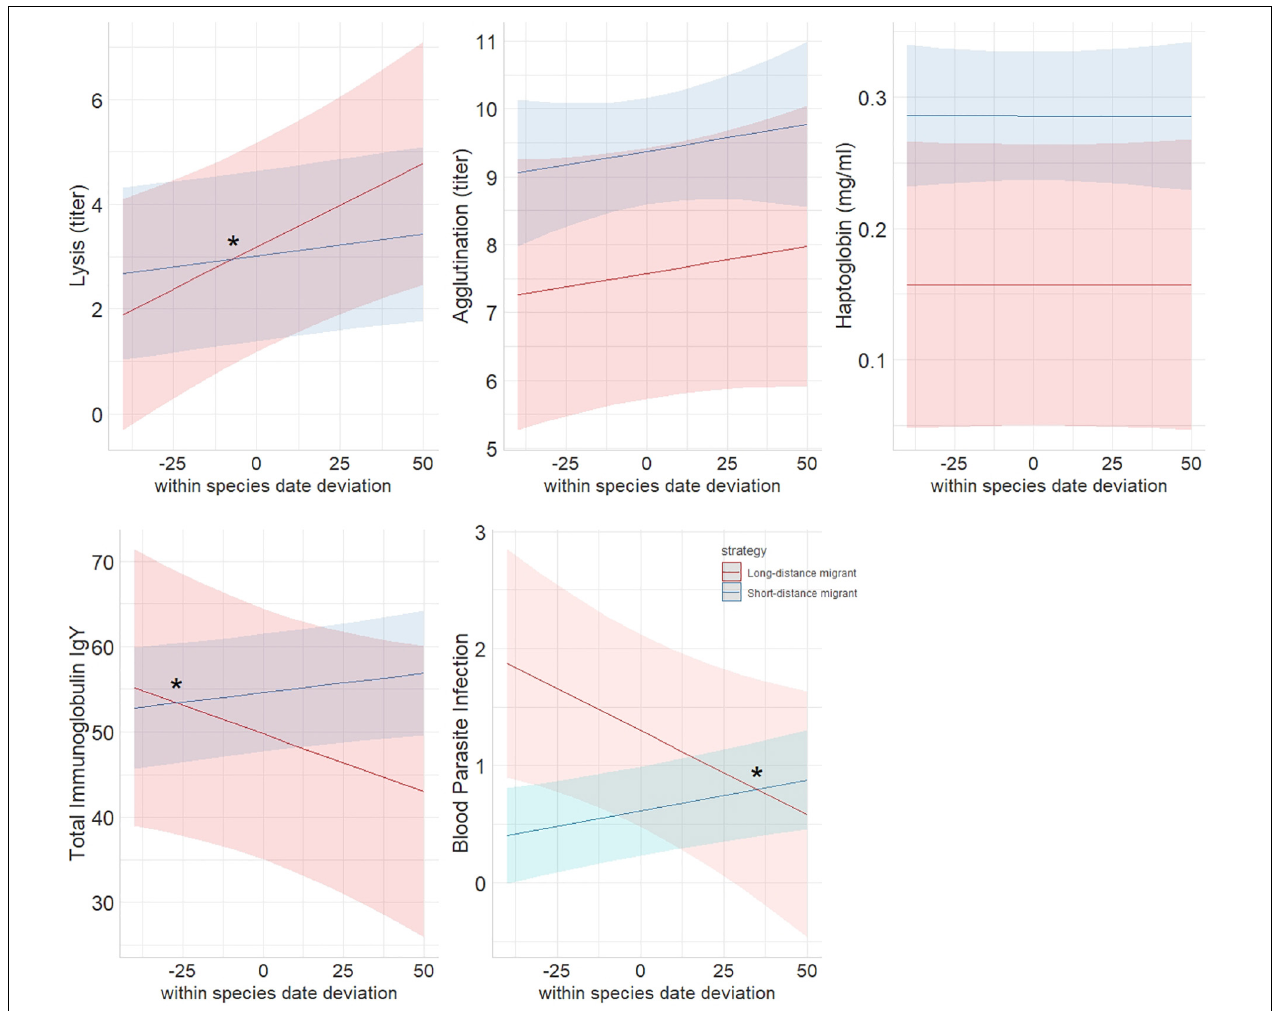
FIGURE 2 | Marginal means from linear mixed models showing within-species-date effect on immune function in long-distance and short-distance migrants sampled during autumn migration at Falsterbo, Sweden. A negative slope means that early migrating individuals have a higher value than late migrating individuals, a positive slope that late migrating individuals have higher values than early migrating individuals. Stars denote significant interactions. Haptoglobin significantly differed between the strategies. For details of statistical results, see section “Results” and Table 1 .